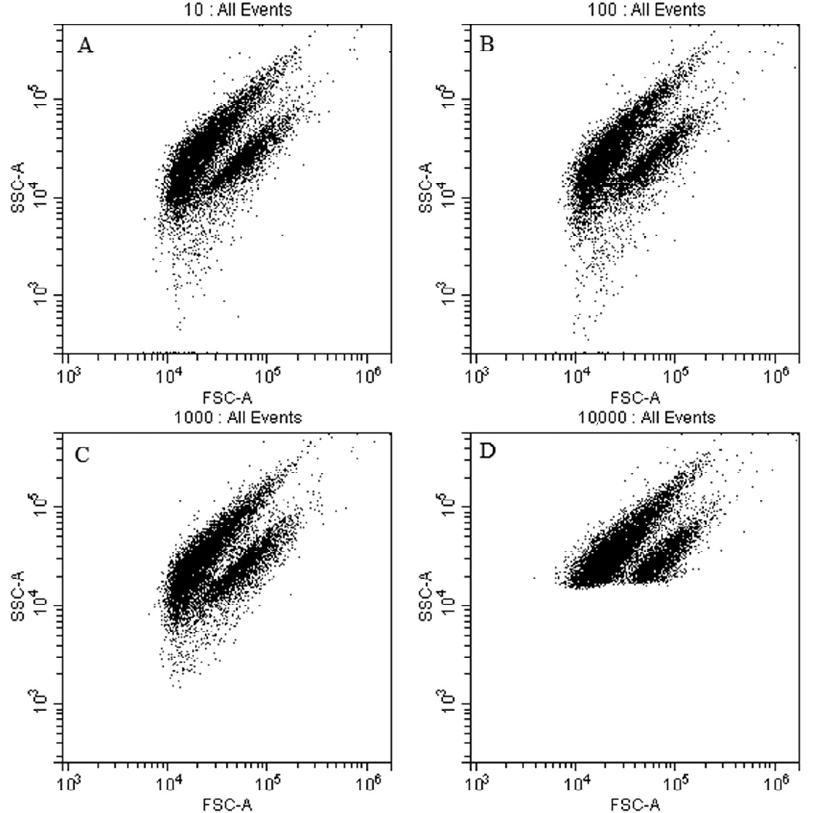
Figure 6. Application of different thresholds of SSC channel. SSC set to ( A ) 10; ( B ) 100; ( C ) 1000; and ( D ) 10,000.